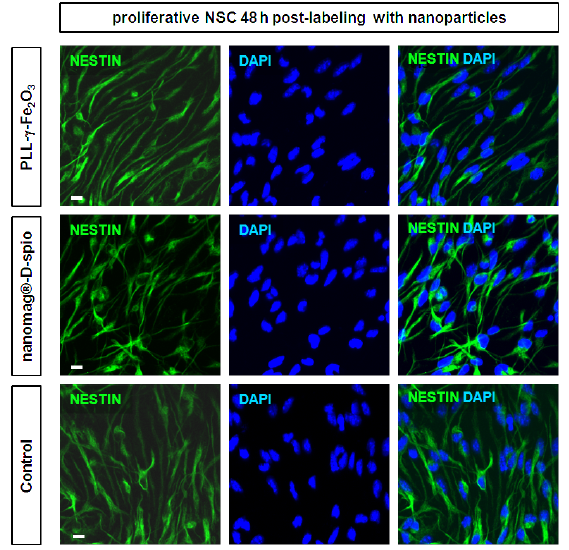
Figure 8: Labeling NSCs with PLL- γ -Fe 2 O 3 and nanomag ® -D-spio nanoparticles did not interfere with their stem/progenitor phenotype. The neural progenitor identity of NSC labeled with PLL- γ -Fe 2 O 3 and nanomag-D-spio was confirmed by immunostaining against nestin (green), marker of neural stem cells, after 48 h of post-labeling prolifer- ation. Control cells were not labeled with any nanoparticles. Nuclear marker DAPI was stained in blue. Scale bars: 10 µm.